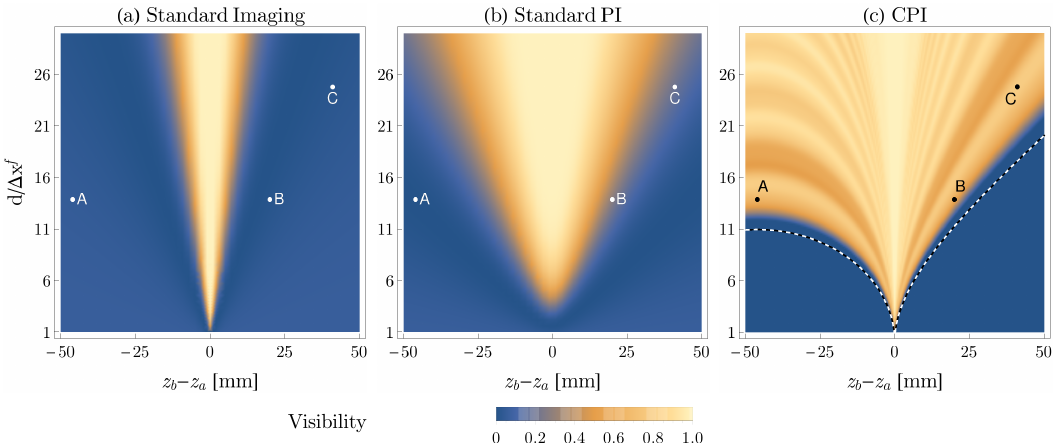
Figure 7. Visibility of double-slit masks in the case of standard imaging ( a ), standard plenoptic imaging with N u = 3 ( b ) and CPI ( c ). The compared devices are characterized by the same numerical aperture of the focusing element employed in the experiment reported in Section 3. The distance d = 2 a between slits is measured in units of the focused image resolution ∆ x f . Points labeled by A, B and C